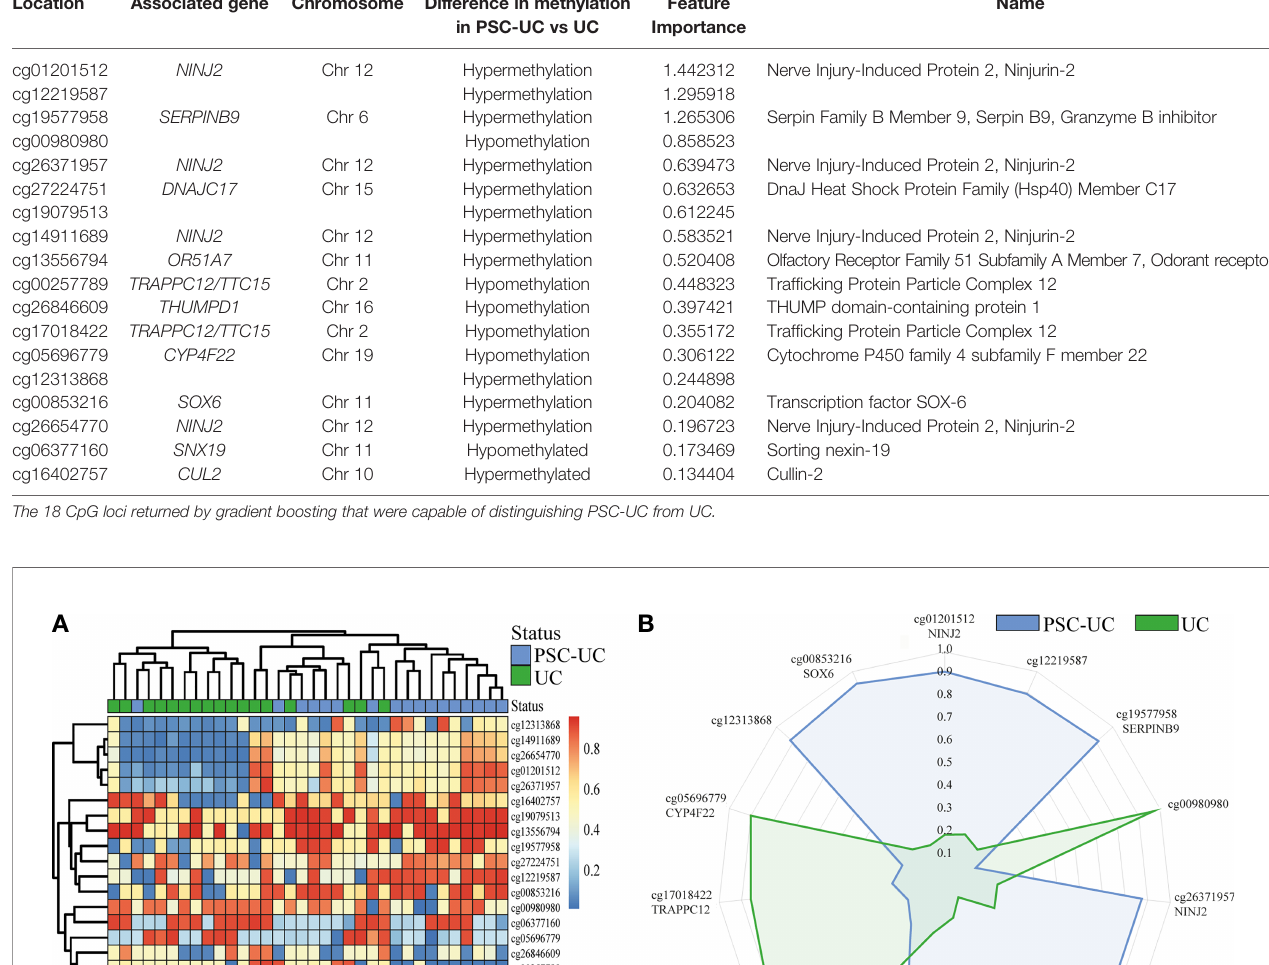
TABLE 3 | Predictor CpG loci capable of distinguishing PSC-UC from UC. Location Associated gene Chromosome Difference in methylation